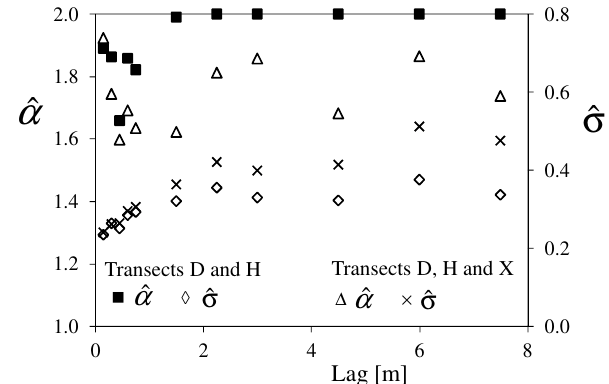
Fig. 11. Variations of ML L´evy index estimates ˆ α and scale parame- ter estimates ˆ σ of Utah log permeability increments with horizontal lag for transects D and H (bioturbated sandstone) and transects D, H and X (bioturbated sandstone and cross-bedded sandstone).